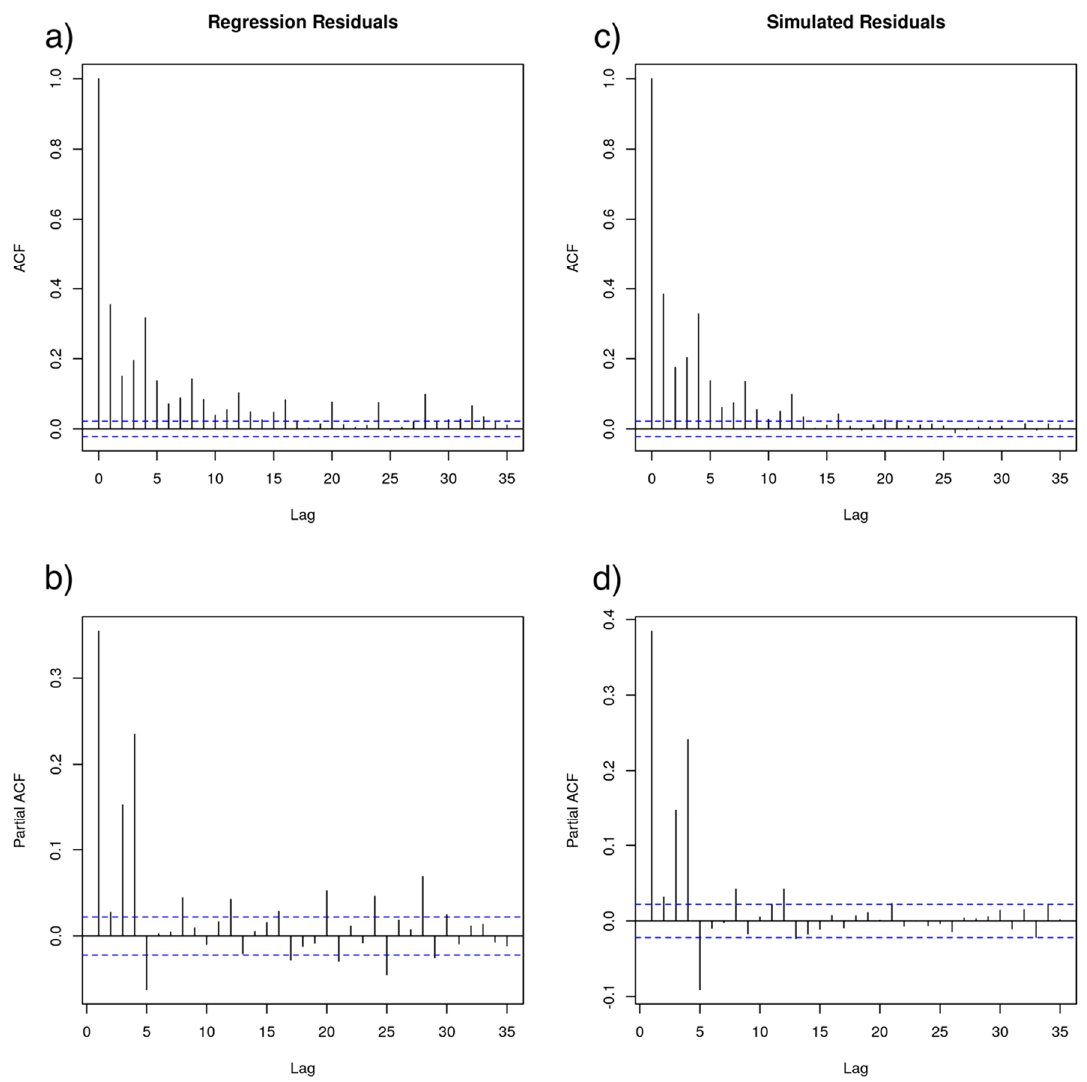
Figure 3. Empirical (panels a , b ) and simulated (panels c , d ) series (P)ACFs for the OBI site. (P)ACF from simulated series mimics the empirical (P)ACF at lower order lags (recent times of the day). An increased number of lags in the seasonal part of the model does not reproduce the empirical (P)ACF at large lags.